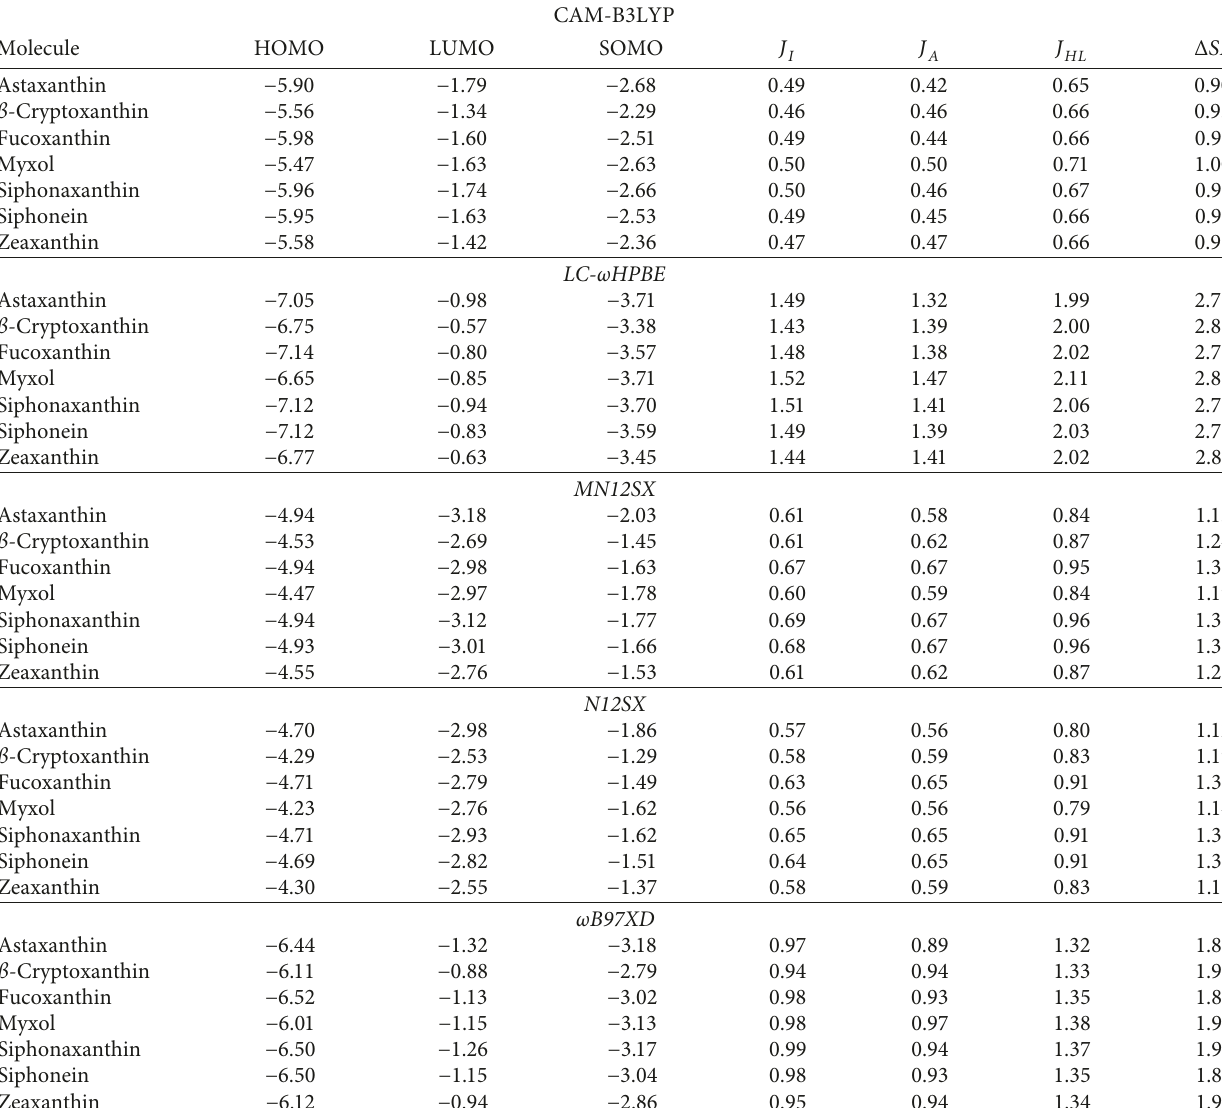
Table 1: HOMO, LUMO, and SOMO orbital energies (in eV) and the KID-related descriptors obtained with the five density functionals, the Def2TZVP basis set, and hexane as the